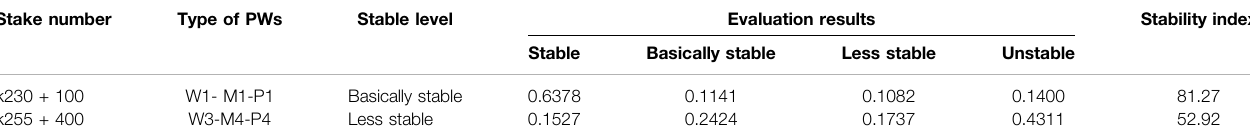
TABLE 14 | Evaluation results.